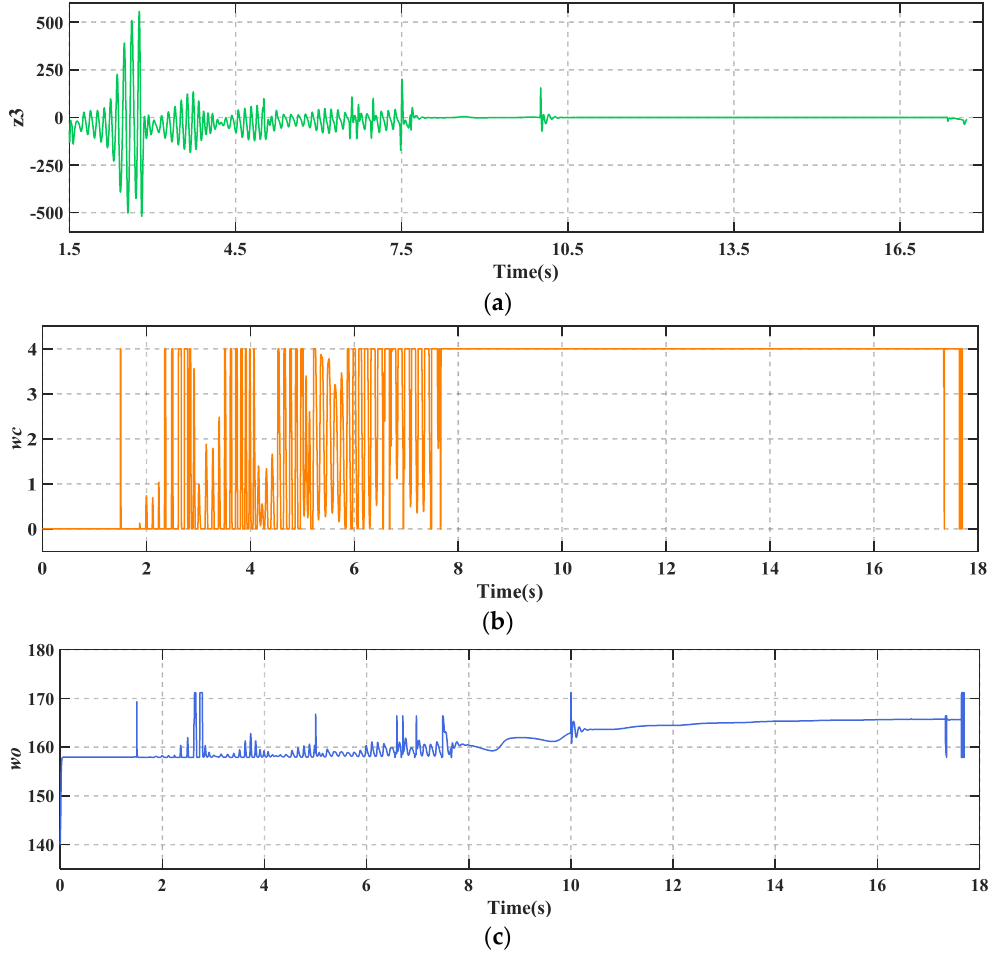
ω ; ( c ) observer bandwidth